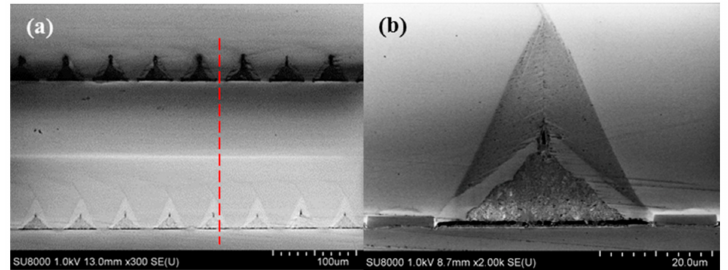
Figure 6. FE-SEM images of the cross section of the sample after two steps of ELO. Panel ( a ) shows an image of the cross section with two ELO layers. Panel ( b ) shows an image of the coalescent